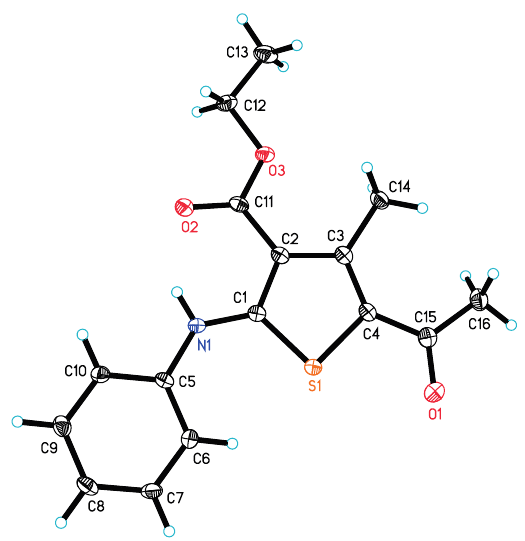
Figure 1. The ORTEP diagram of the final X-ray model of compound 2 with displacement ellipsoids drawn at 50% probability level. H-atoms were placed and not included in refinement, except H1 attached on N1.